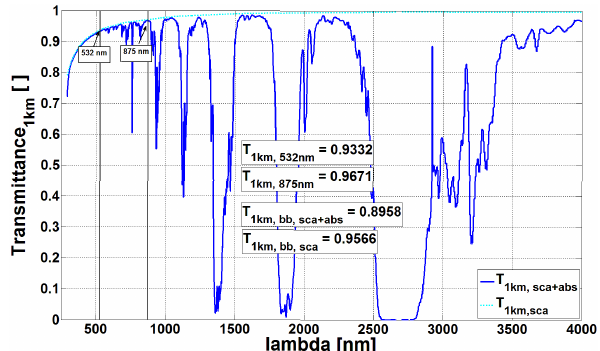
Figure 3. Spectral transmittance (blue, solid line) and spectral trans- mittance without absorption (cyan, dotted line) for a slant range of 1km, 29 May 2013, 12:00:00UTC, PSA. Vertical lines show the location of the LPV4 transmissometer (532nm) and the FS11 scat- terometer (875nm) measuring